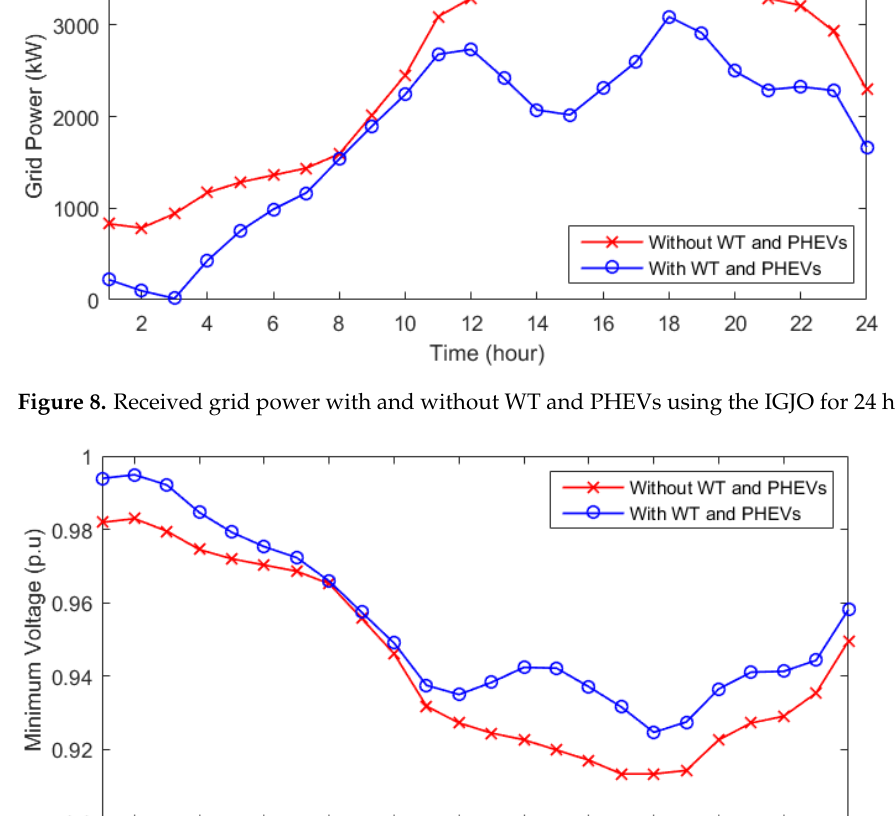
Figure 7. Power loss of the 33-bus distribution network with and without WT and PHEVs using the IGJO.